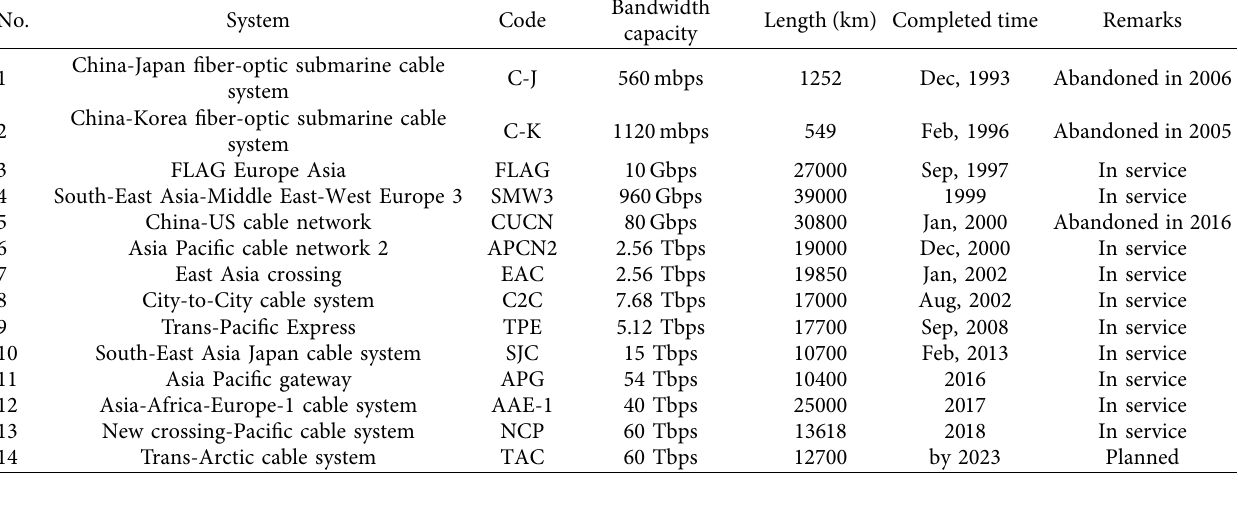
Table 1: Major international submarine cable systems landing in Mainland China.